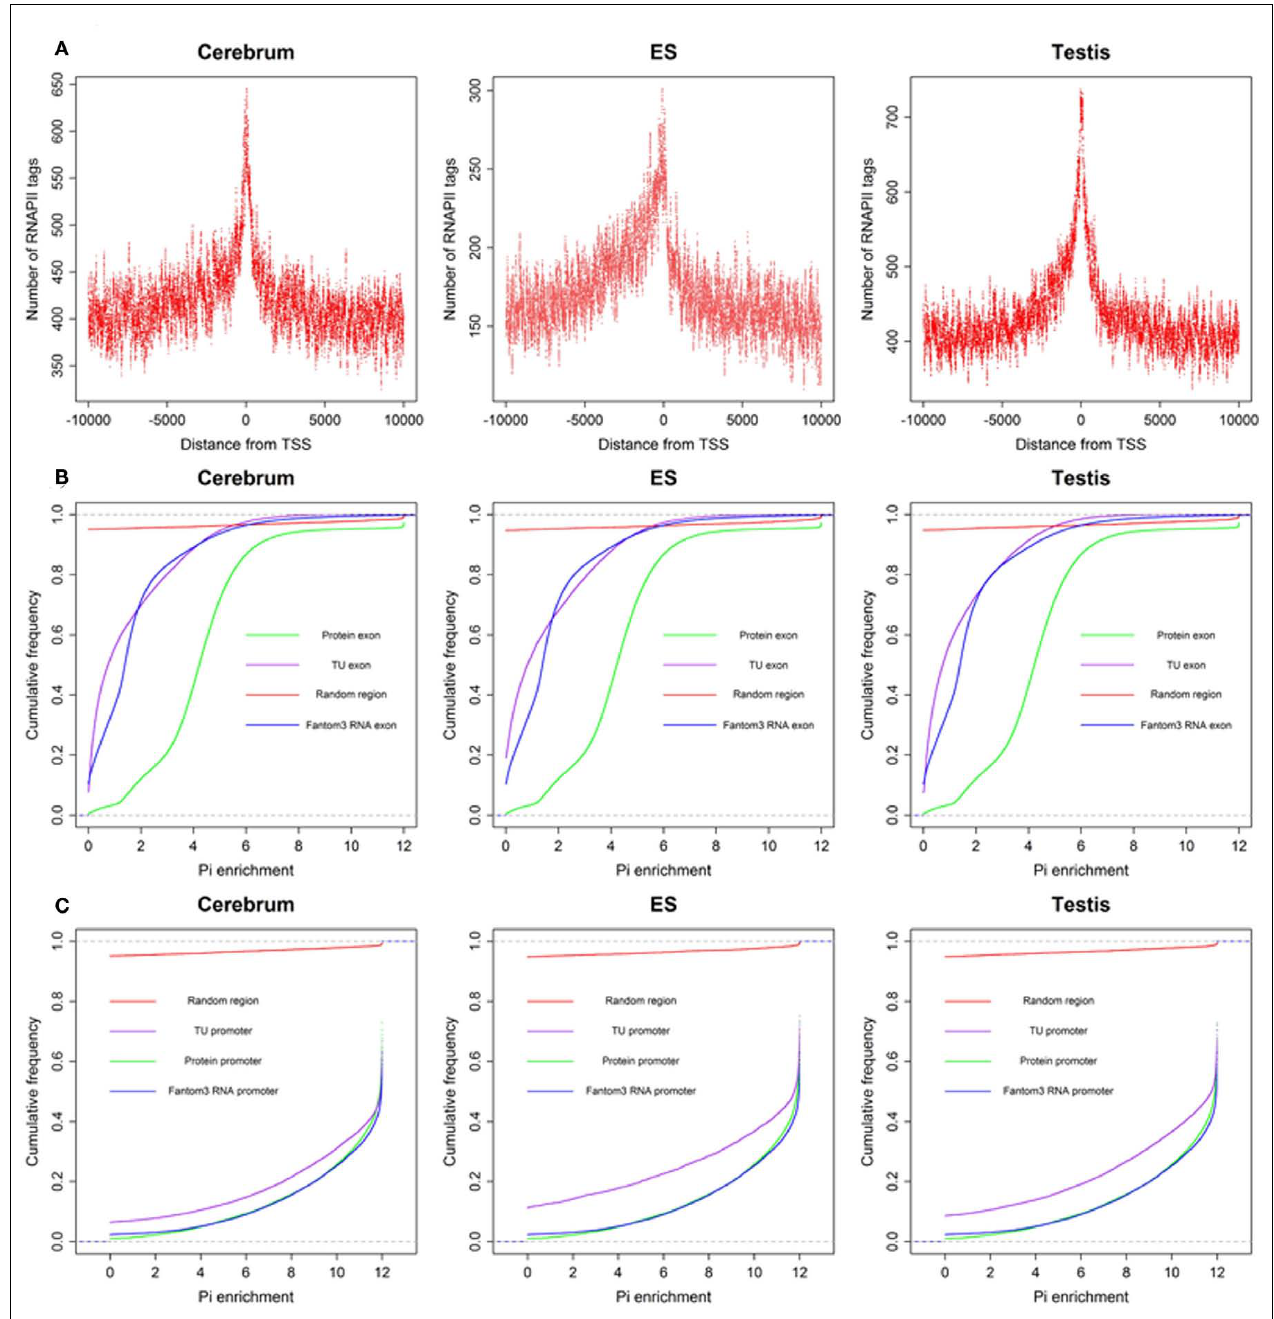
Fantom3 RNA exon, and random region, and (C) cumulative distribution of sequence conservation forTU promoter, protein promoter, Fantom3 RNA promoter, and random